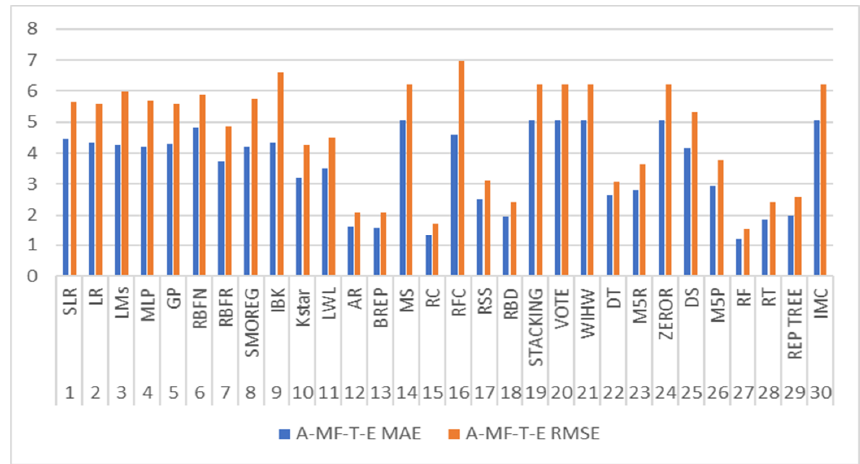
Figure 10. MAE and RMSE of the different machine learning models.